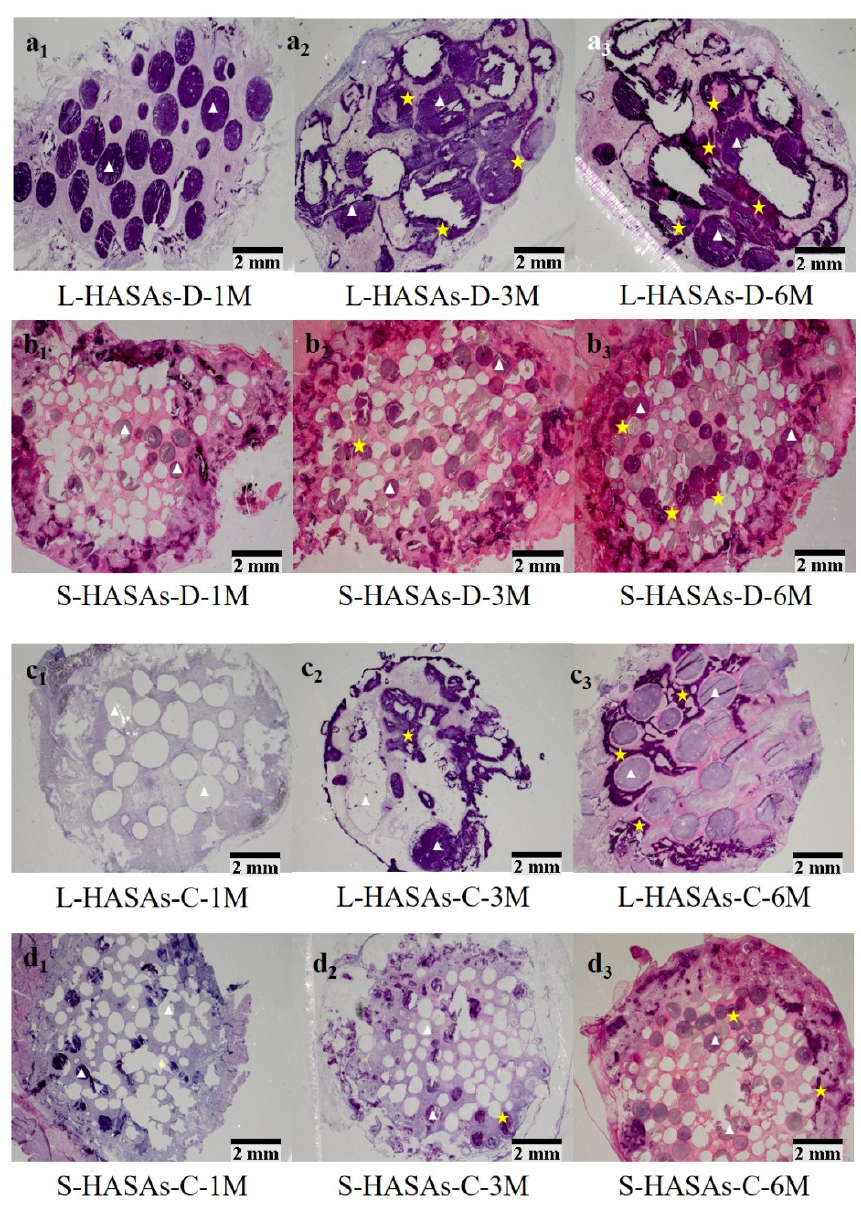
Figure 2. Relationship between ectopic bone formations of HASAs and the macropore sizes implanted in dorsal muscle/abdominal cavity by H&E staining. ( a 1 – a 3 ) L-HASAs implanted 1, 3 and 6 months, ( b 1 – b 3 ) S-HASAs implanted 1, 3 and 6 months, ( c 1 – c 3 ) L-HASAs implanted 1, 3 and 6 months, ( d 1 – d 3 ) S-HASAs implanted 1, 3 and 6 months. With the implantation time extended, new bone tissues were found in all scaffolds, which was better in the L-HASAs than those in the S-HASAs. White triangles show HA materials, yellow stars show new bone. The bar = 2 mm.